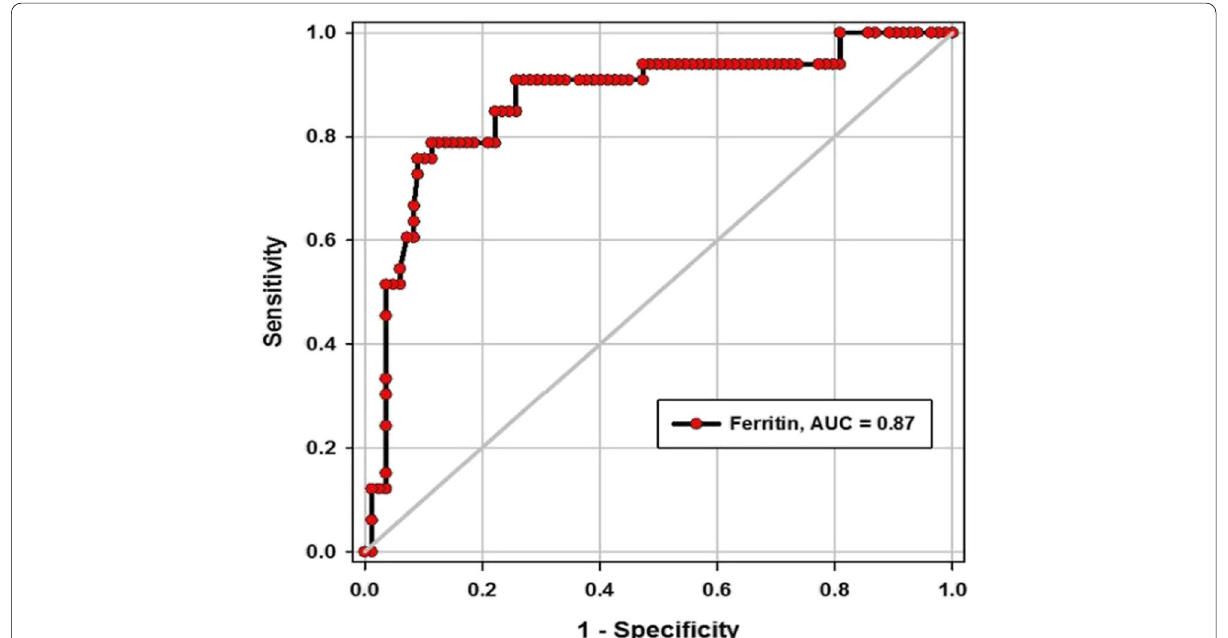
Fig. 3 Receiver operating characteristic (ROC) curve for serum ferritin in predicting severity of